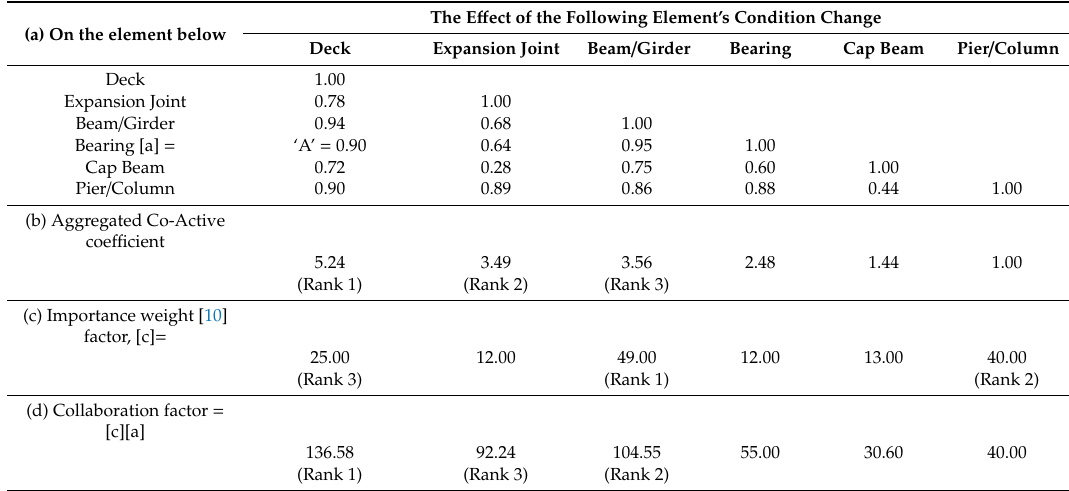
Table 5. Co-Active prioritization parameters in the ‘SO107’ group.